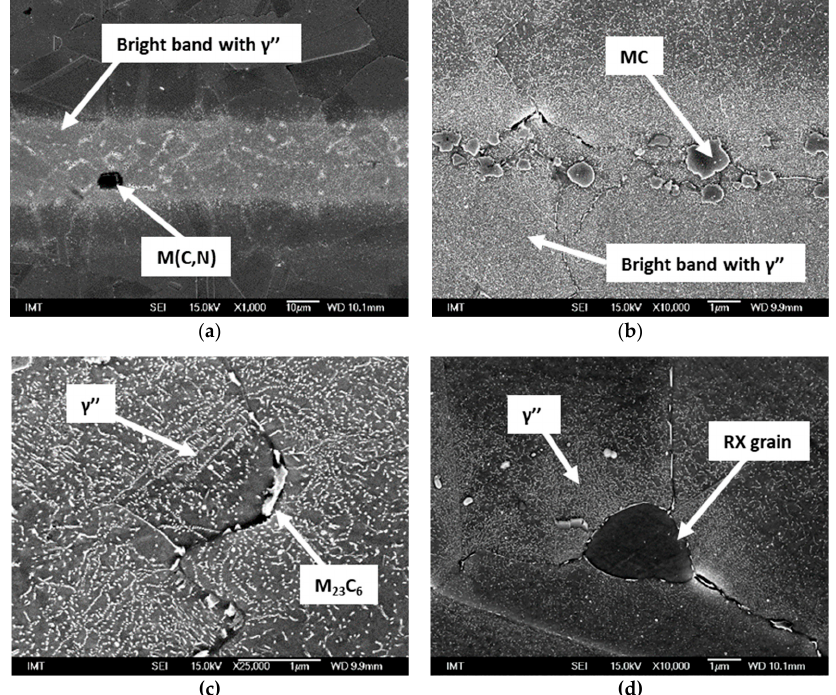
Figure 5. The precipitation of γ ’’ in the segregation band for the samples hot rolled at 1050 °C with the deformation level of 4.6% and aged at 750 °C for 1 h ( a ). Primary MC carbides in the samples hot rolled at 1150 °C with the deformation level of 5.7% and aged at 750 °C for 1 h ( b ). Bulged grain boundary in the samples hot rolled at 1150 °C with the deformation level of 5.7% and aged at 750 °C for 1 h ( c ). Recrystallized grain with no γ ’’ precipitates in the sample hot rolled at 1050 °C with the deformation level of 12.7% and aged at 750 °C for 1 h ( d ). Table 3. Composition of different phases obtained by EDS analysis (wt.